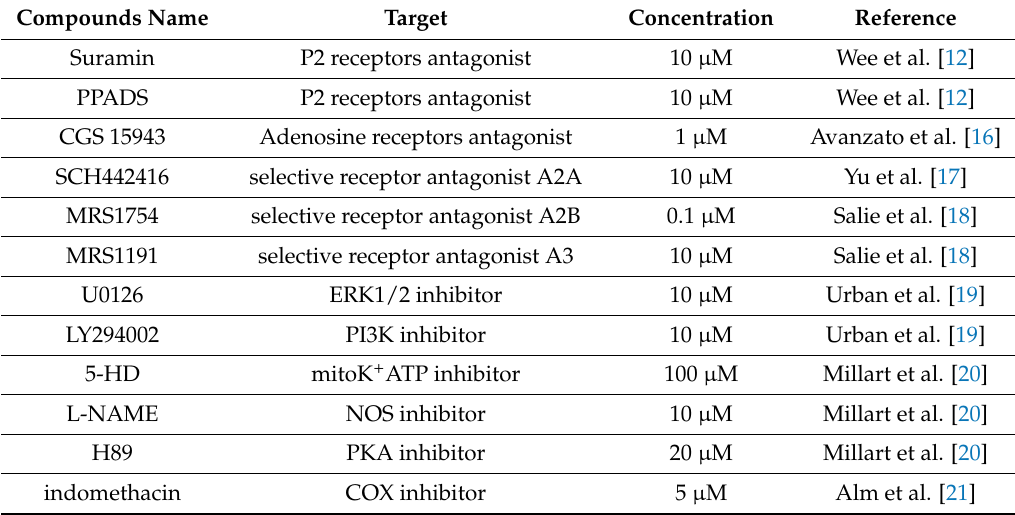
Table 1. Panel of inhibitors and antagonists.